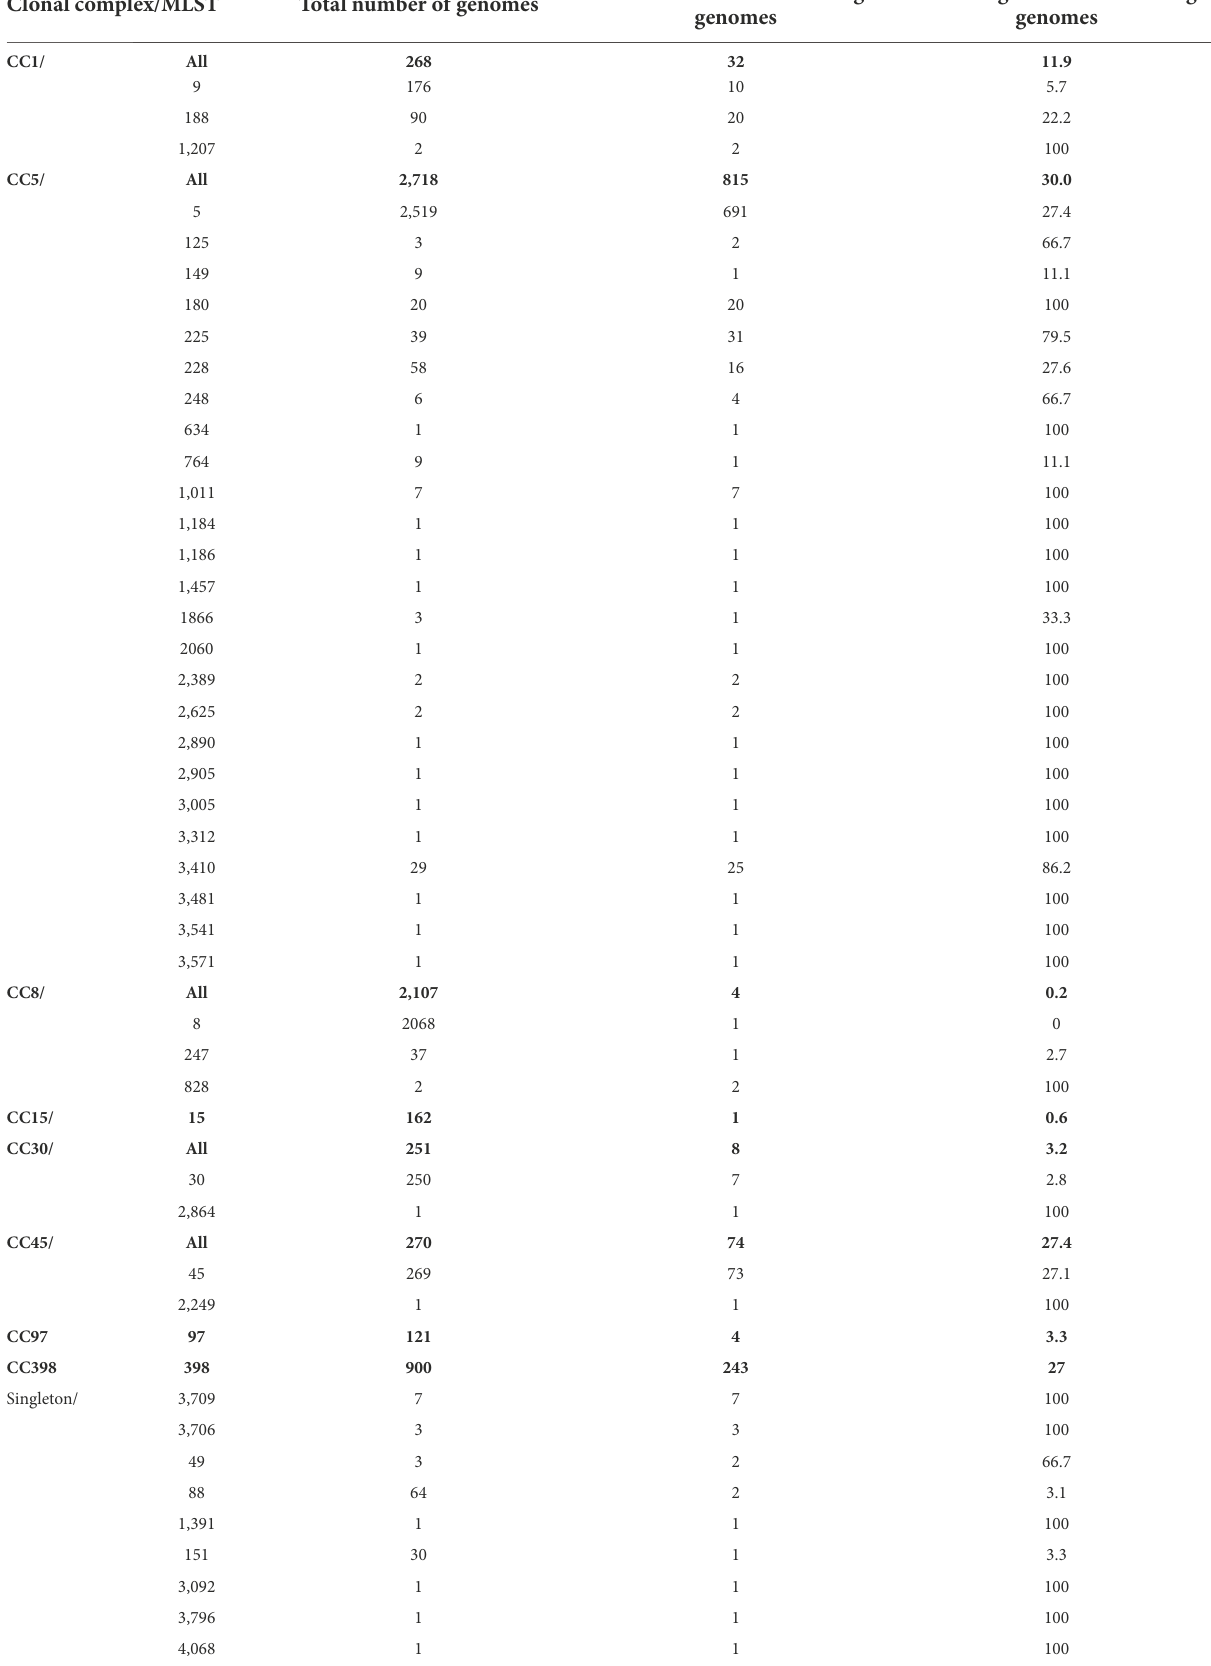
TABLE 1 Abundance of tarP -positive S. aureus sequence types (MLST) in the used BLAST dataset. Clonal complex/MLST Total number of genomes